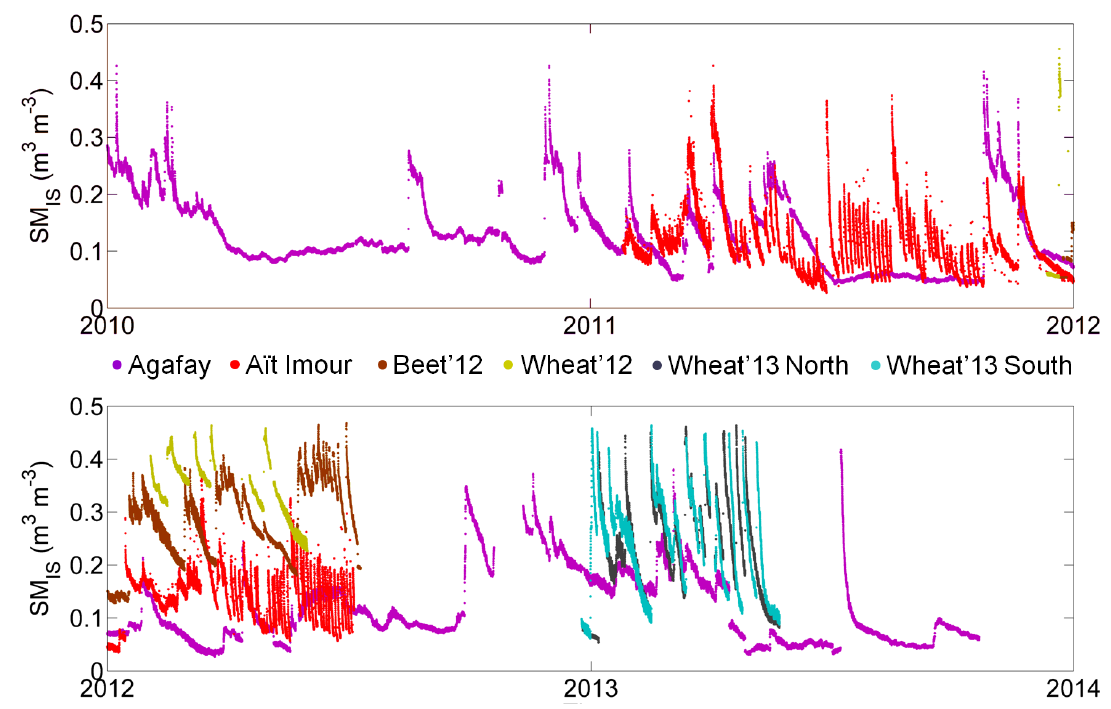
Figure 2. In situ soil moisture time